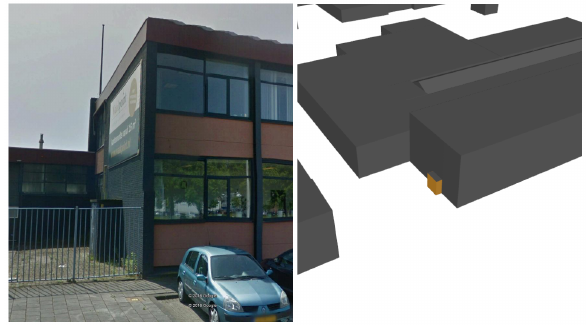
Figure 2. Shared features such as overhangs found in Rotterdam with its own unique parent identifier